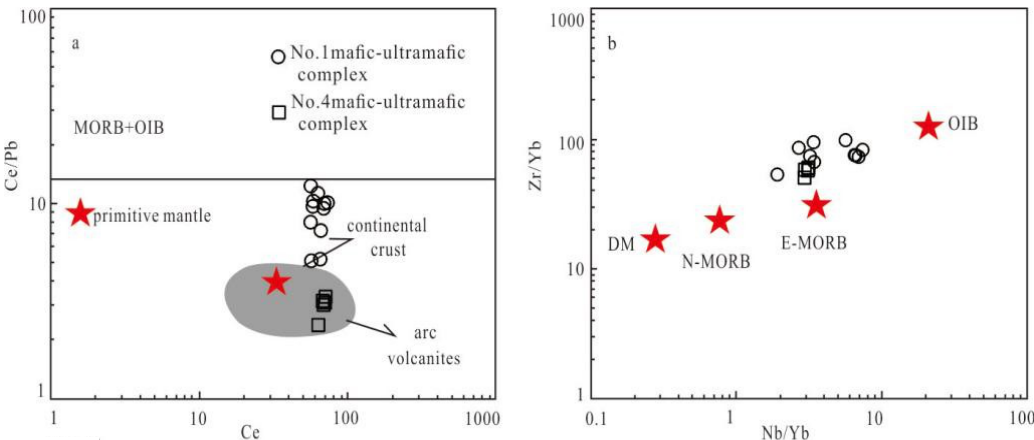
Figure 11. ( a ) Ce / Pb vs. Ce; ( b ) Zr / Yb vs. Nb / Yb plots of the Akechukesai IV mafic–ultramafic complex. Primitive mantle, DM, mid-ocean ridge basalt (MORB) and OIB from Hofmann [40], Schmidberger and Hegner [46], Harms et al. [47], Taylor and McLennan [48], Pearce et al. [49], Fitton et al.